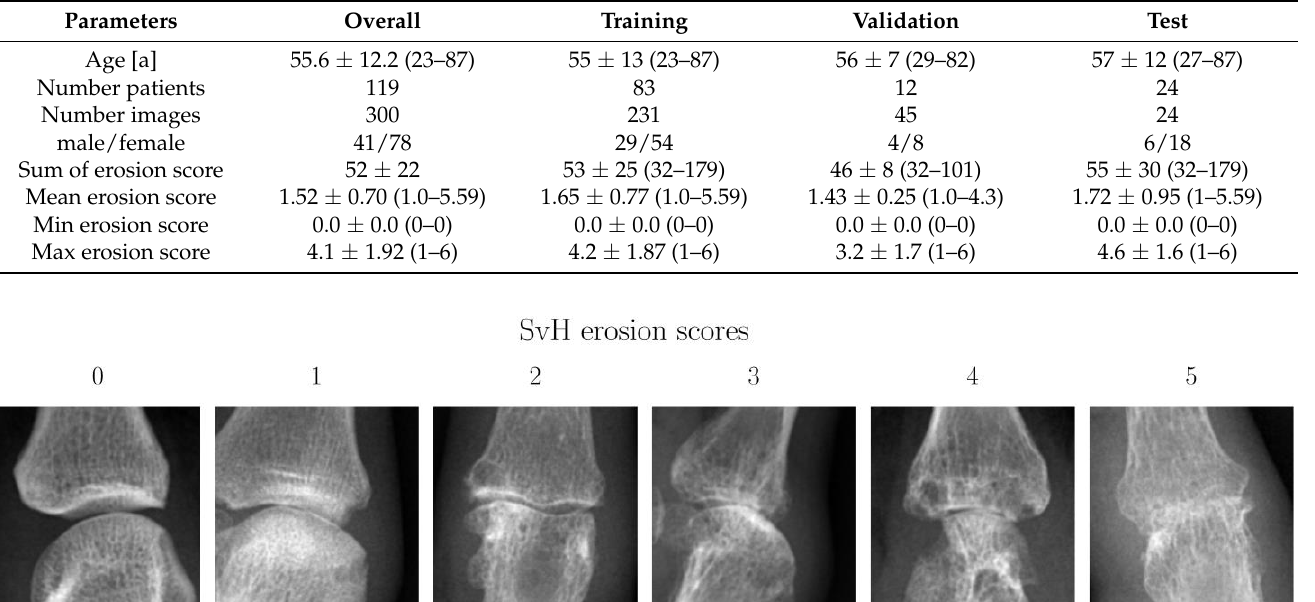
Table 1. Overview of the demographic and medical characteristics of the patients as function of group. All values are shown as mean ± standard deviation; in brackets, the range is additionally given if useful. If more than one X-ray image were available for a patient, the age and scoring at the time of the first X-ray were used.